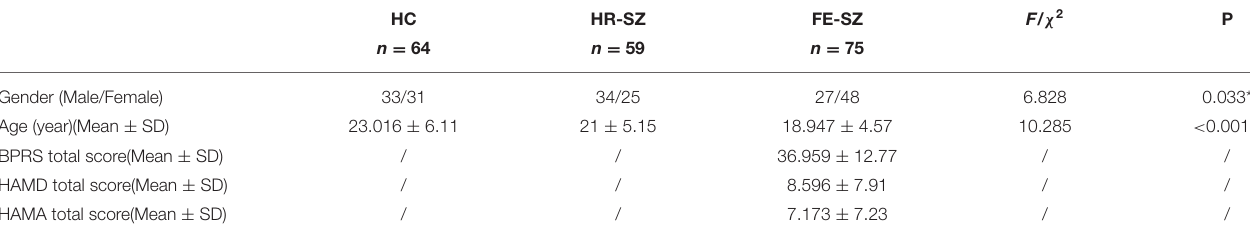
TABLE 1 | Statistical results of the clinical data.